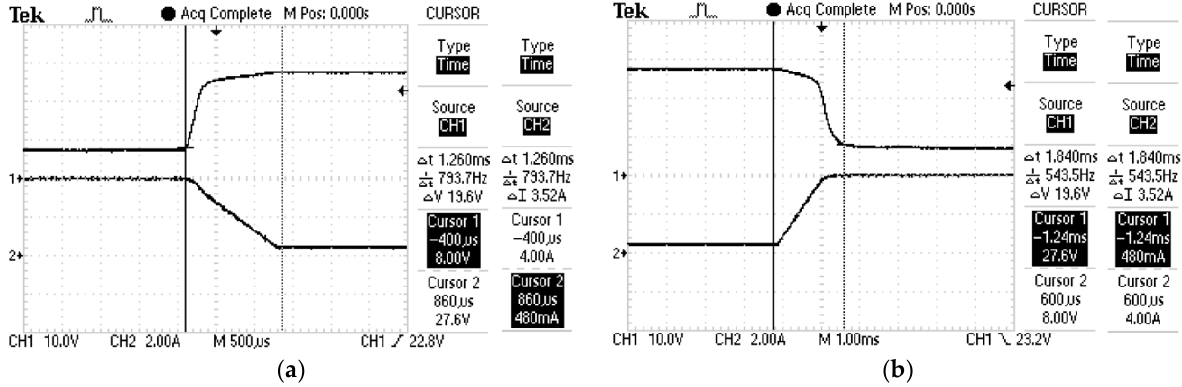
Figure 15. Responses of the PVE output to Ro steps under the operating conditions 4 A/28 V: ( a ) The output response for the increase step change of resistances from 2 Ω to 57 Ω ; ( b ) The output response for the decrease step change of resistances from 57 Ω to 2 Ω .